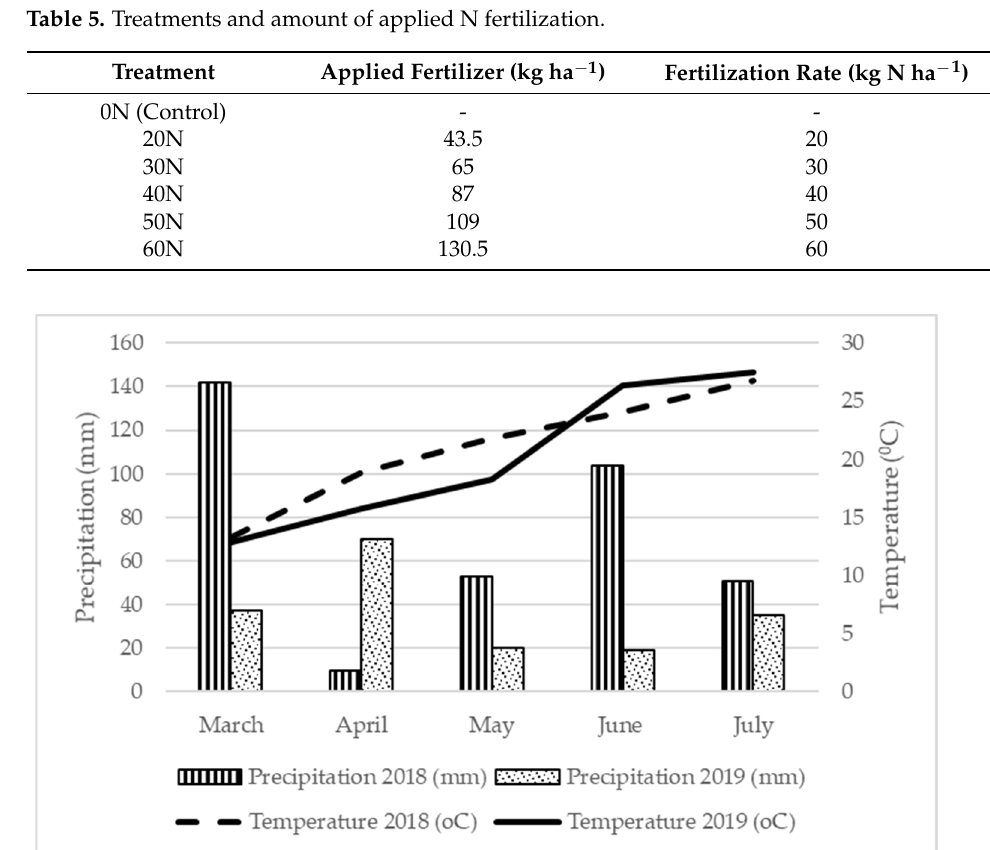
Figure 2. Mean monthly temperature (°C) and precipitation (mm) recorded on the experimental fields throughout the duration of the experiments (March–July, 2018–2019). Table 4. Soil properties of the experimental